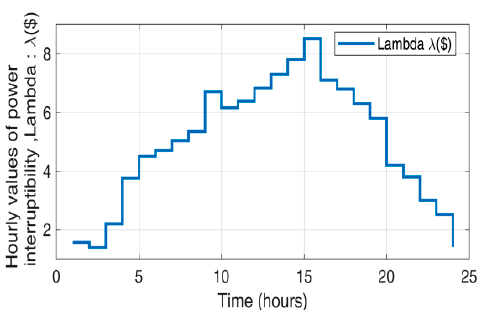
Figure 3. Load curve.